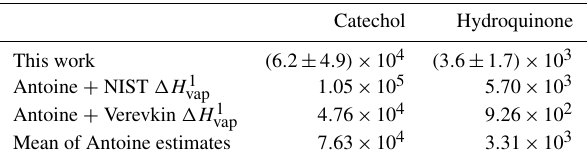
Table 2. Measured and literature-derived C ∗ benzenediol